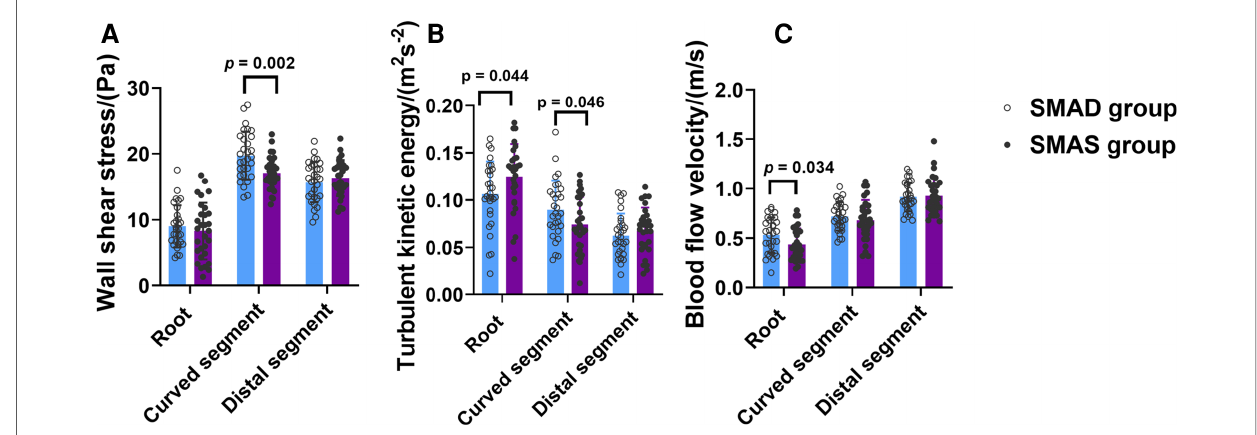
FIGURE 4 The comparison of hemodynamic parameters, including Wall shear stress (WSS) ( A ), turbulent kinetic energy (TKE) ( B ), and blood fl ow velocity (BFV) ( C ), in the three segments (root, curved and distal segment) of the superior mesenteric artery (SMA) in the superior mesenteric artery dissection (SMAD) and superior mesenteric atherosclerotic stenosis (SMAS) groups.